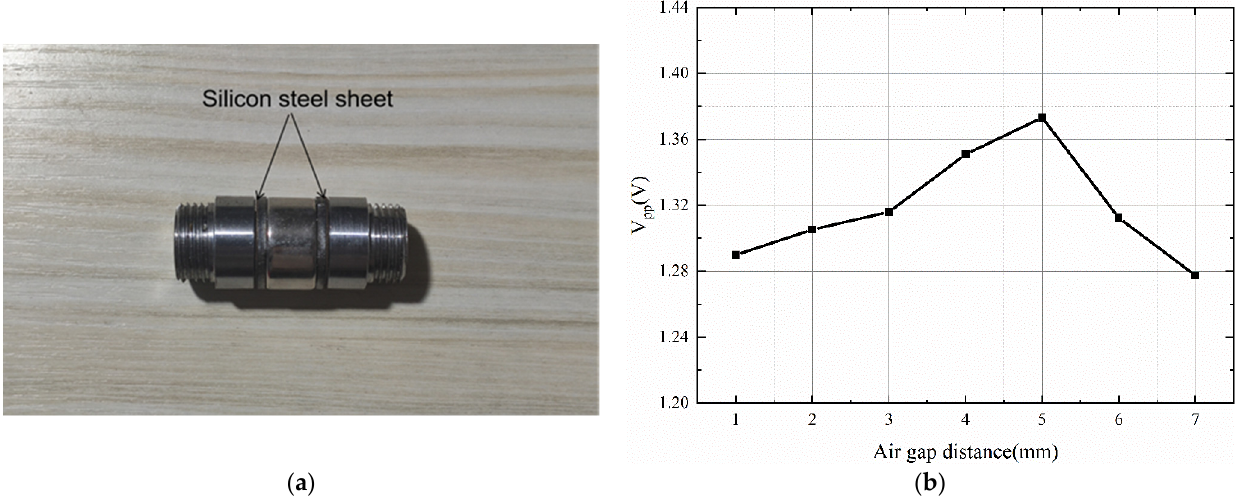
Figure 12. Experimental verification for different air gap: ( a ) silicon steel sheet adjusts the air gap distance of the sensor; ( b ) the V pp values of the induced voltage for different air gap.